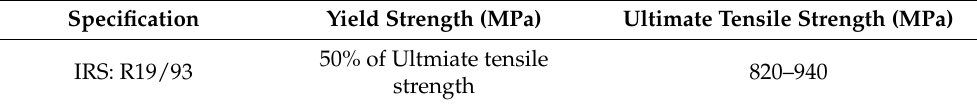
Table 2. Mechanical properties of wheel